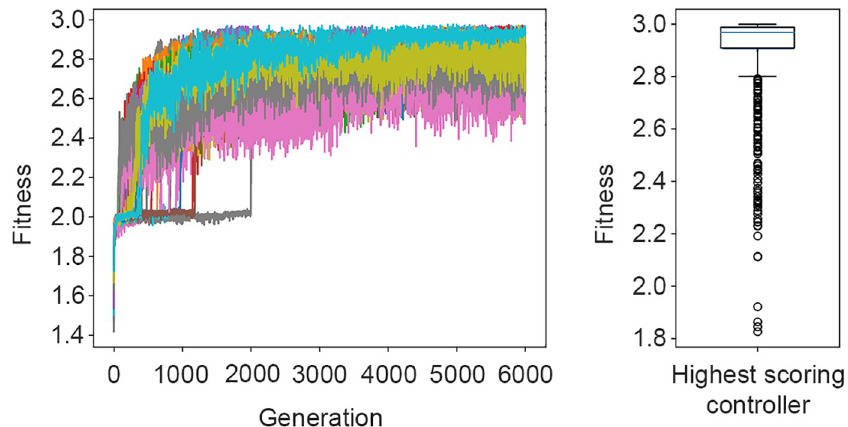
Fig 4. Left: Fitness trajectories of the controllers in each of the 6000 generations. Right: Distribution of the post- evaluation fitness scores achieved by the highest-scoring controller.